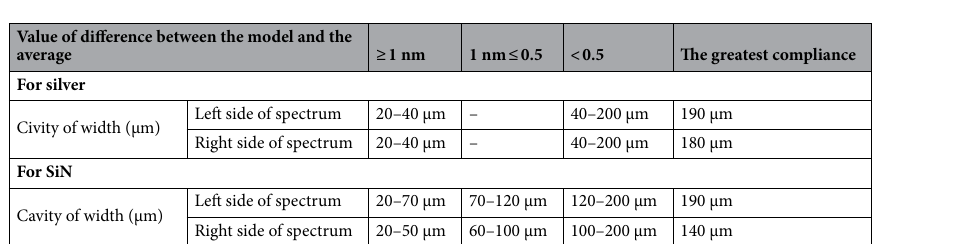
Value of difference between the model and the